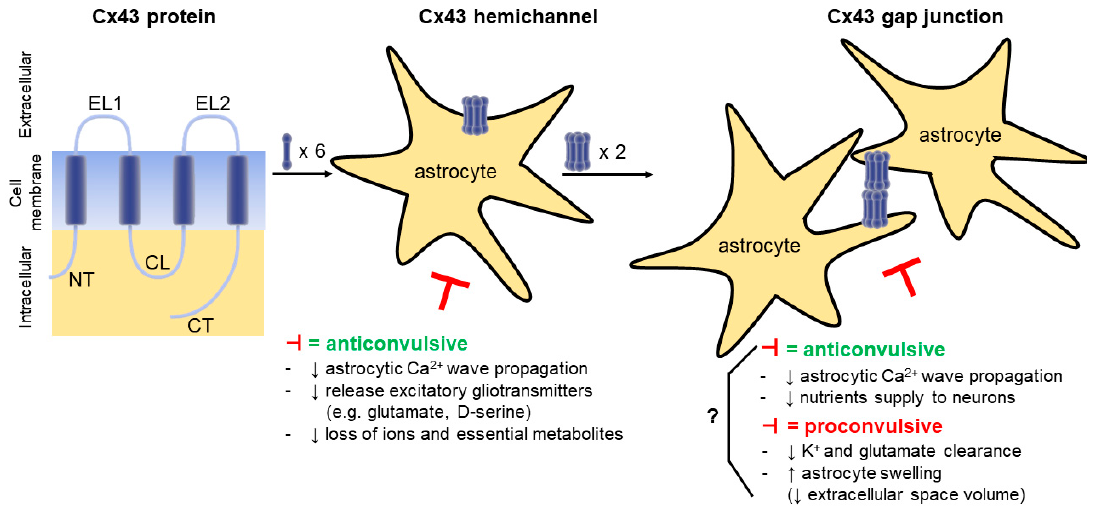
Figure 1. Schematic diagram illustrating connexin43 (Cx43) protein, hemichannel (HC), and gap junction (GJ) and their involvement in seizures. ( Left ) Each Cx43 protein has four transmembrane domains, two extracellular loops (EL1-2), one cytoplasmic loop (CL), and C- and N-terminal tails (CT and NT). Its mRNA, protein expression levels, phosphorylation state, and distribution can be altered in experimental seizure models and tissue from patients with epilepsy. ( Middle ) A Cx43 HC is built up by six Cx43 proteins and forms a channel between the astrocytic cytosol and the extracellular environment. Cx43 HC inhibition ( ⊣ ) can be anticonvulsant by decreasing ( ↓ ) astrocytic Ca 2+ wave propagation, release of excitatory gliotransmitters and loss of ions, essential metabolites. ( Right ) A Cx43 GJ is formed by docking of two Cx43 HCs from adjacent astrocytes. Cx43 GJ inhibition ( ⊣ ) can be both pro- and anticonvulsant. Ictogenic properties originate from decreased ( ↓ ) K + and glutamate redistribution and increased ( ↑ ) astrocyte swelling; anticonvulsant properties are due to decreased ( ↓ ) astrocytic Ca 2+ wave propagation (hypersynchronization) and trafficking of nutrients to neurons.